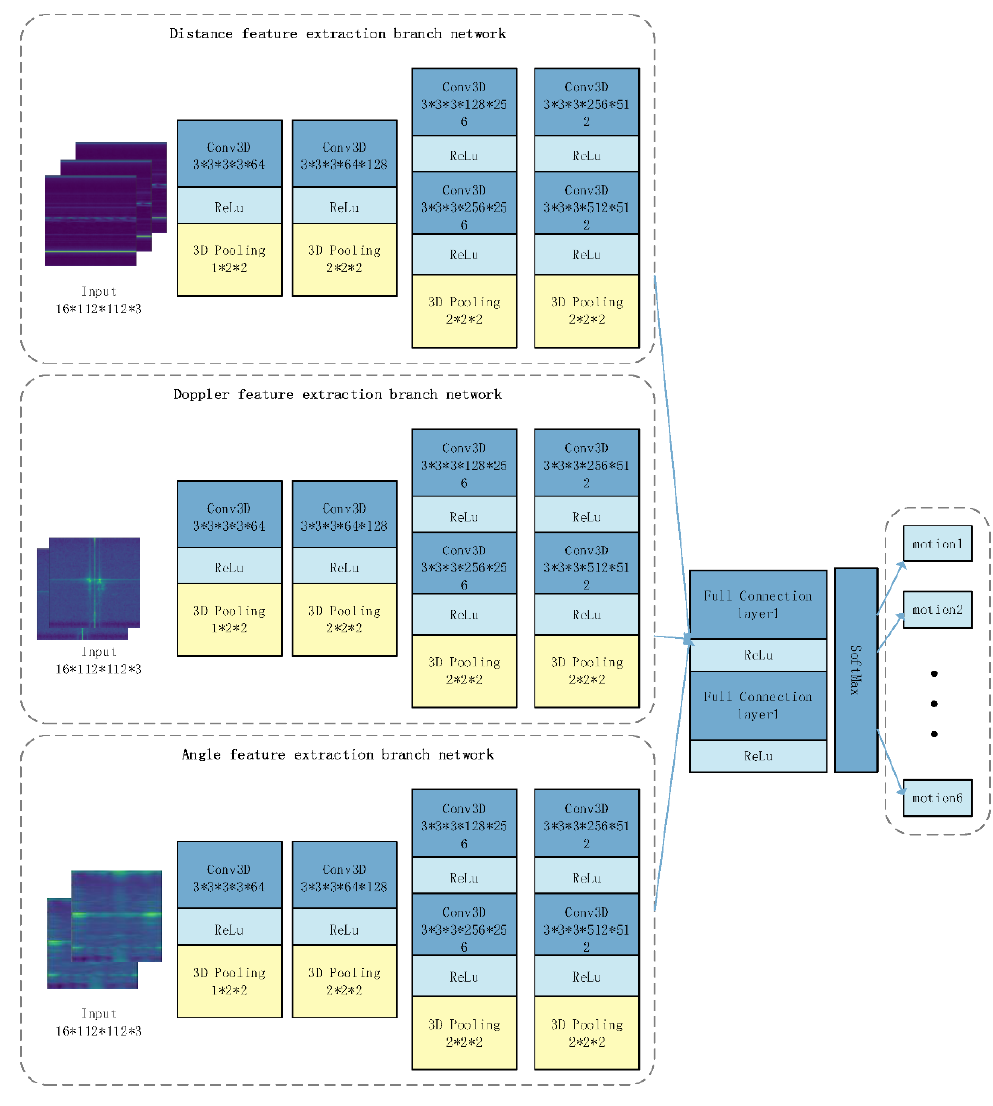
Figure 6. Architecture of the three-dimensional CNN.